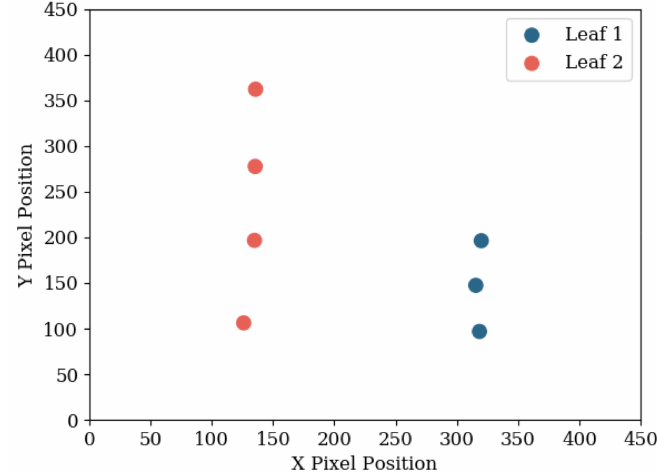
Figure 8. Detections from the images in Figure 6 which have been grouped according to the origin leaf. The linearity of the camera’s movement causes the separation between detection to be almost linear. As the detections of Leaf 2 are more spread out, the leaf is known to be located closer to the